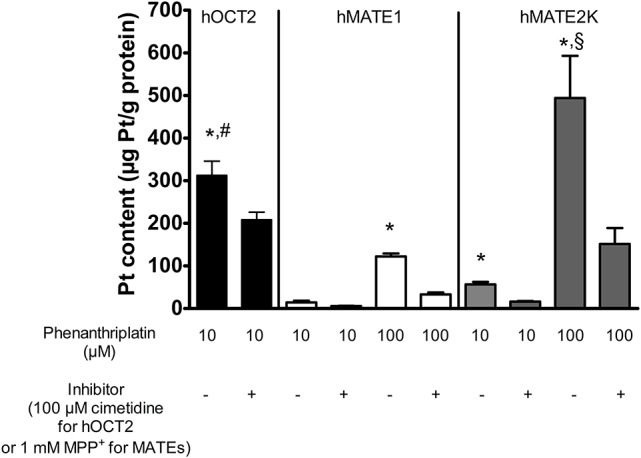
Platinum concentration in lysates from HEK293 cells stably transfected with hOCT2 (black columns), hMATE1 (white columns), or hMATE2K (gray columns) after incubation with phenanthriplatin measured by ICP-MS (n = 3–8). The cells were incubated 10 min with 10 μM (hOCT2) or 100 μM (hMATE1 and hMATE2K) phenanthriplatin (Phen) alone or together with 100 μM cimetidine (hOCT2) or 1 mM MPP+ (hMATE1 and hMATE2K). *indicates a significant difference from all the respective experiments with inhibitor (unpaired t-test); #indicates a significant difference from the other experiments with 10 μM phenanthriplatin alone (ANOVA); §indicates a significant difference from all other experiments in the presence of 100 μM phenanthriplatin (ANOVA).